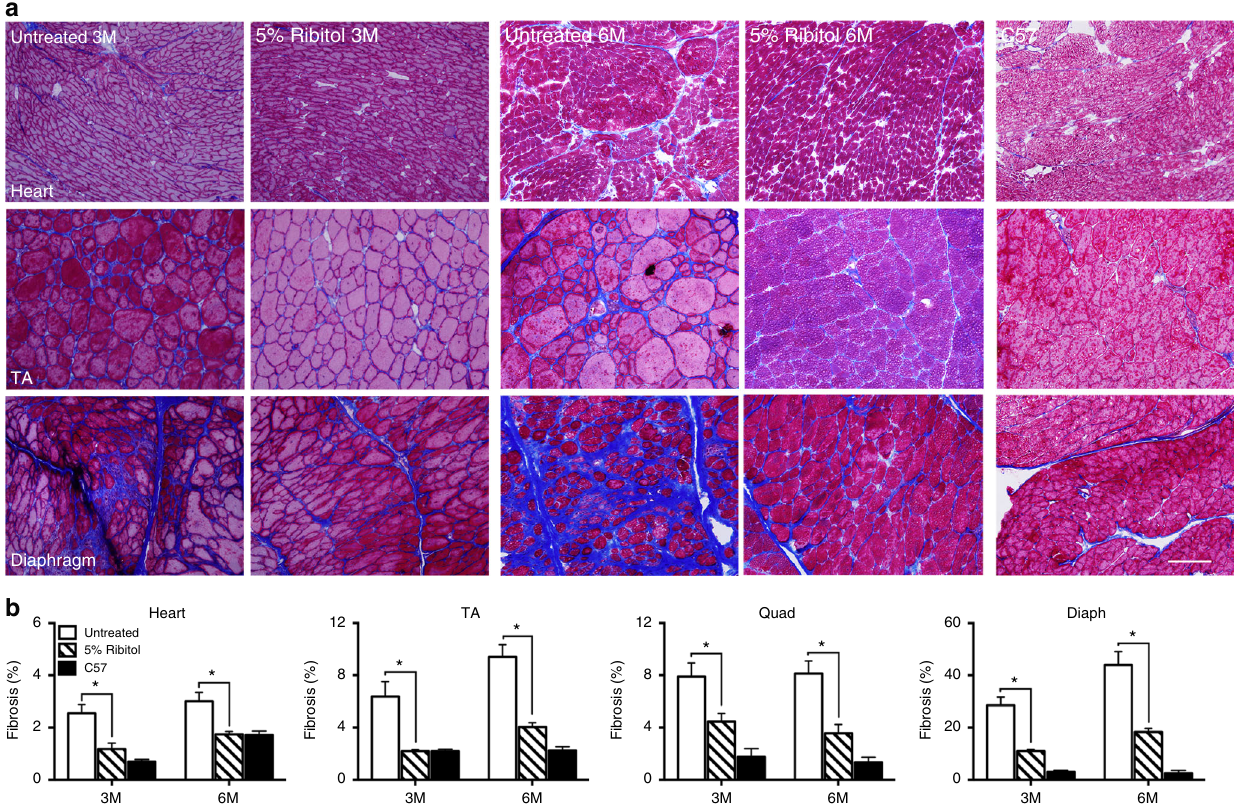
Fig. 5 Effect of ribitol treatment on muscle fi brosis in P448L mice. Seven-week-old P448L mice were given drinking water only or drinking water supplemented with 5% ribitol for either 3 months (3M) or 6 months (6M). a Masson ’ s Trichrome staining of heart, tibialis anterior (TA), and diaphragm muscles from untreated (untreated 3M and untreated 6M) or 5% ribitol-treated (5% ribitol 3M and 5% ribitol 6M) P448L and C57 mice. Blue staining represents area of fi brotic tissue. Scale bar, 100 μ m. b Percentage of fi brotic areas quanti fi ed from Masson ’ s Trichrome staining of 3 months (3M) and 6 months (6M) untreated and 5% ribitol-treated heart, TA, quadriceps (QUAD), and diaphragm (DIAPH) muscles ( n = 6 for 3M, n = 4 for all other cohorts). Error bars represent mean ± SEM. Unpaired t test, * p ≤